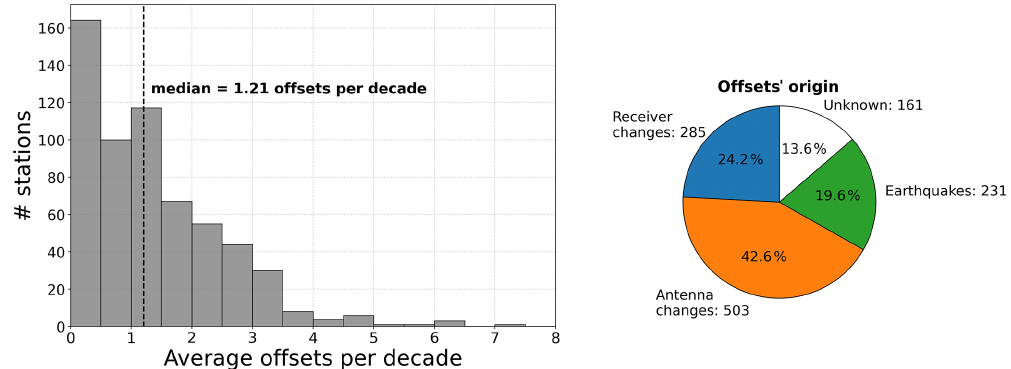
Figure 3. Average station position offsets per decade (histogram) and offsets’ origins (pie chart).